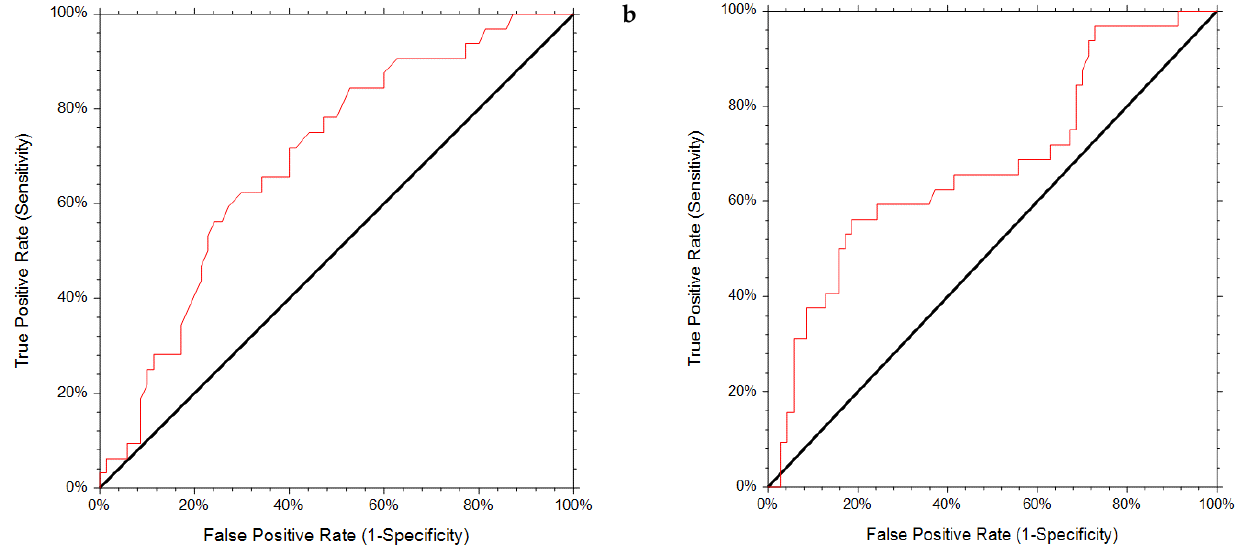
Figure 2. Receiver operating characteristic (ROC) curves for ( a ) handgrip strength test and ( b ) 4 m gait speed